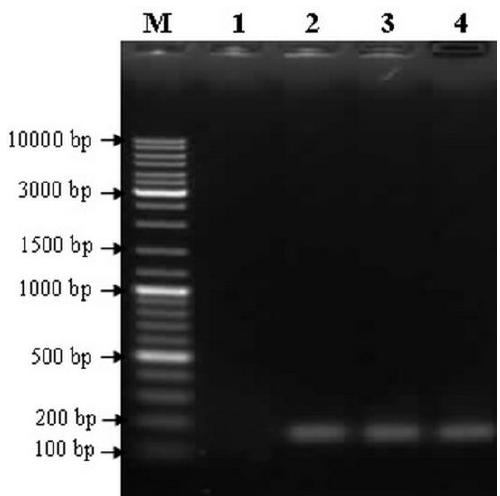
Figure 2. Determination of the transcription start site using 5′-RACE. Lane M: 2-log DNA marker (New England Biolabs, UK); Lane 1: negative control using total RNA without reverse transcriptase; Lanes 2−4: SMARTer RACE PCR products from different cDNA as